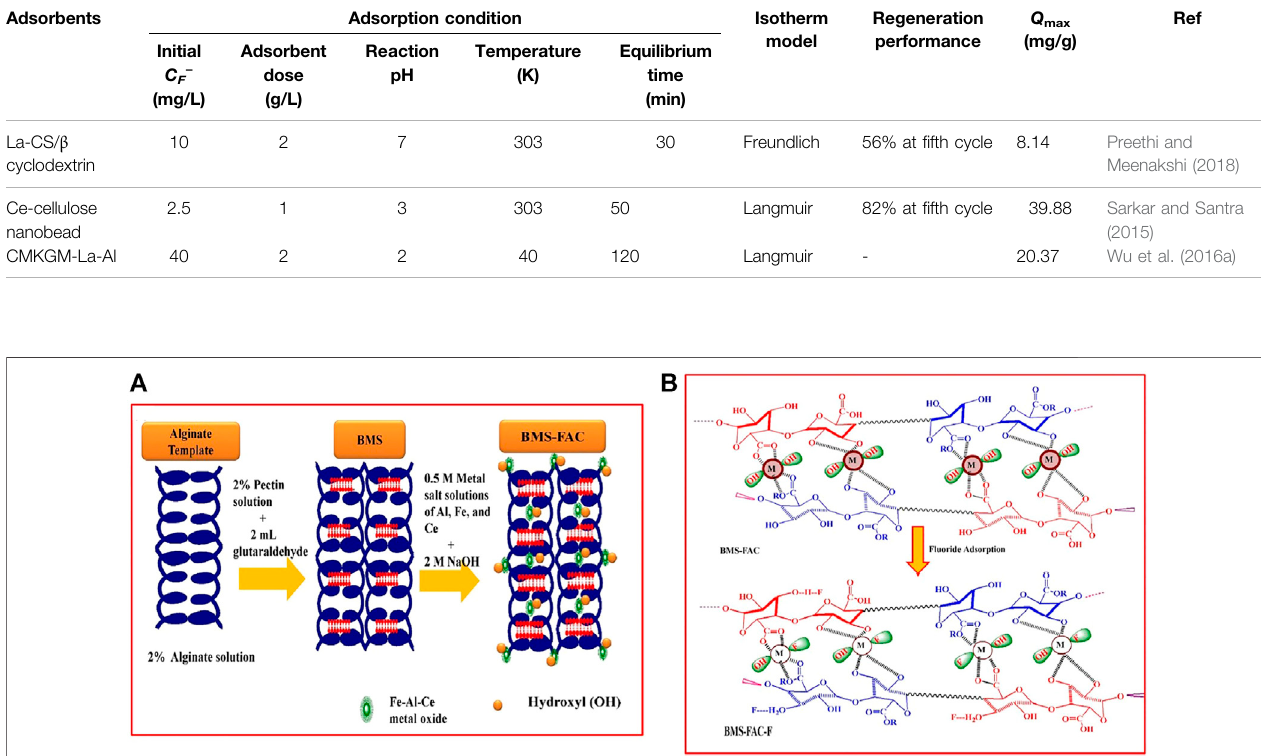
Frontiers in Chemistry |